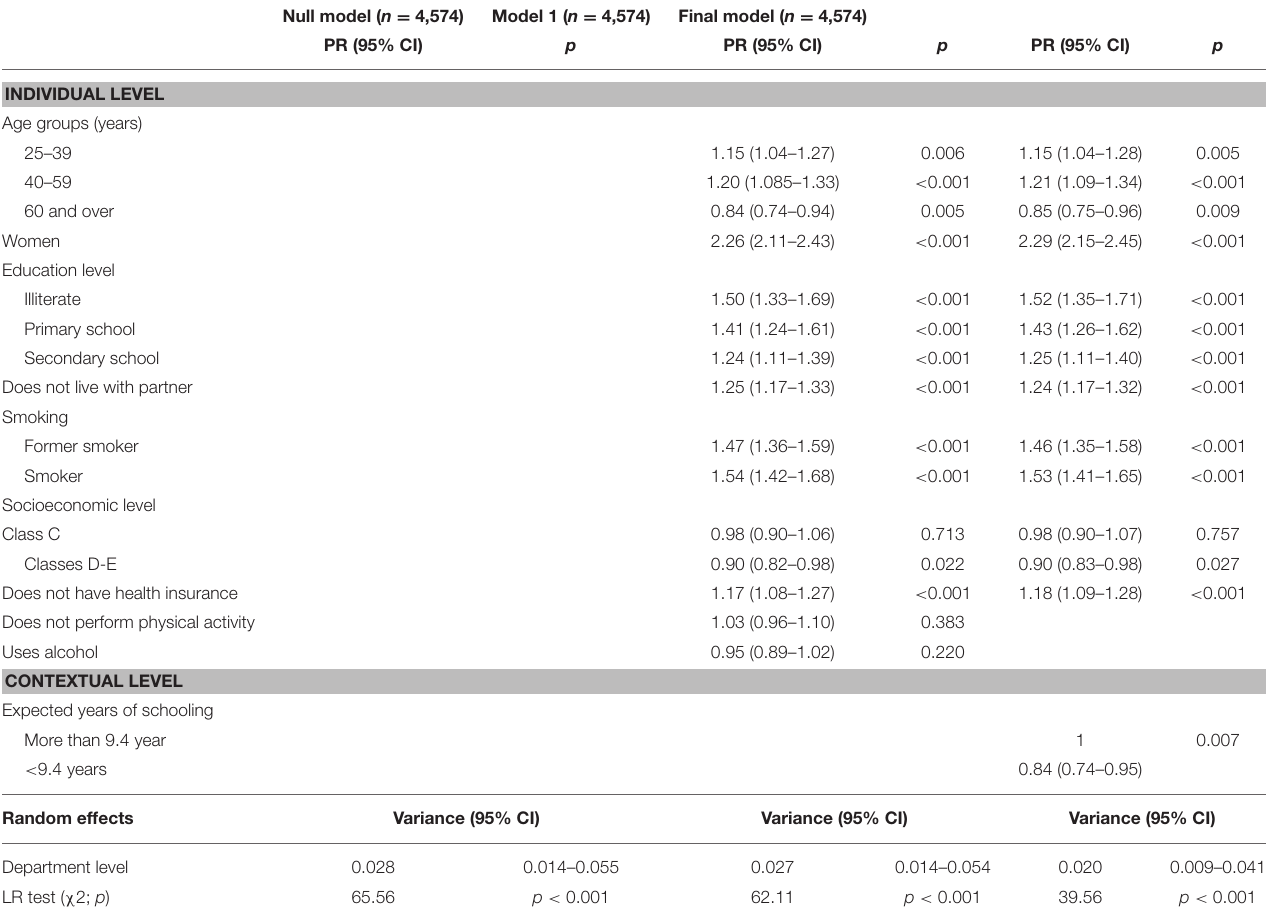
TABLE 3 | Multilevel poisson regression analysis for the outcome “Depressive thoughts” in the 2013 Brazilian National Health